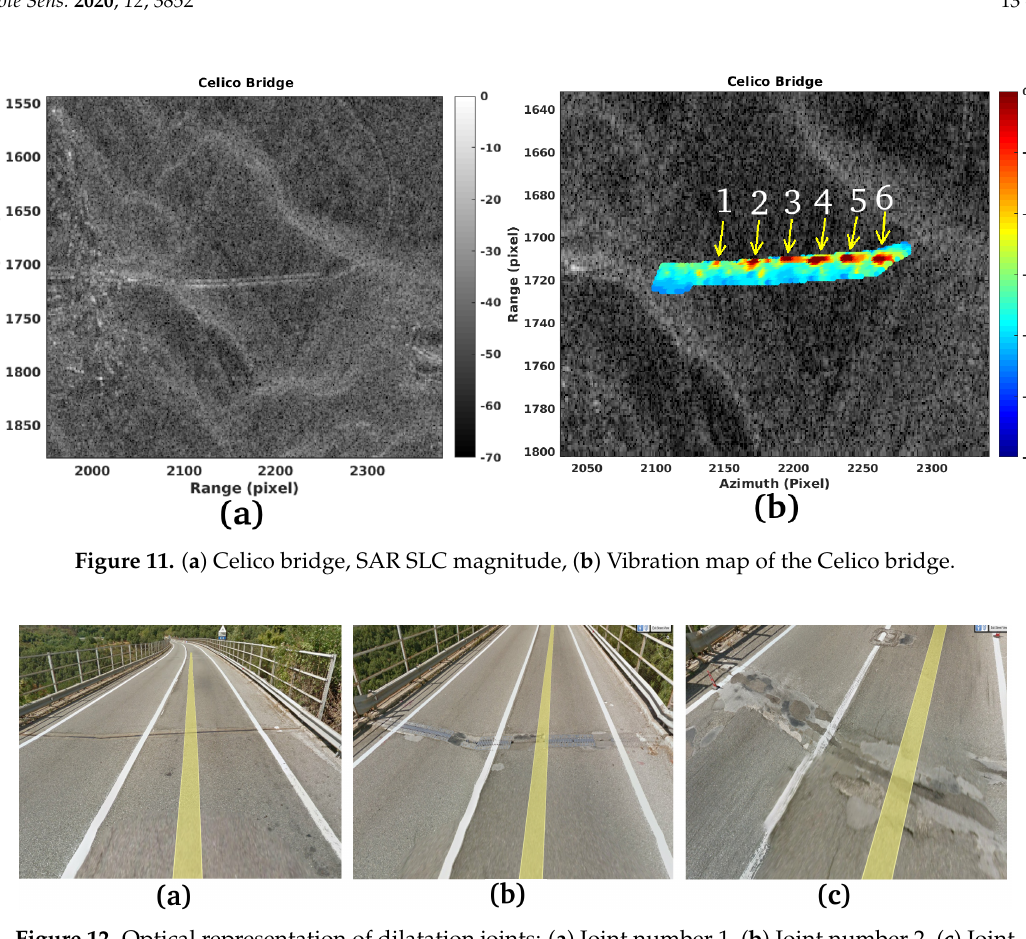
Figure 12. Optical representation of dilatation joints: ( a ) Joint number 1, ( b ) Joint number 2, ( c ) Joint number 3.